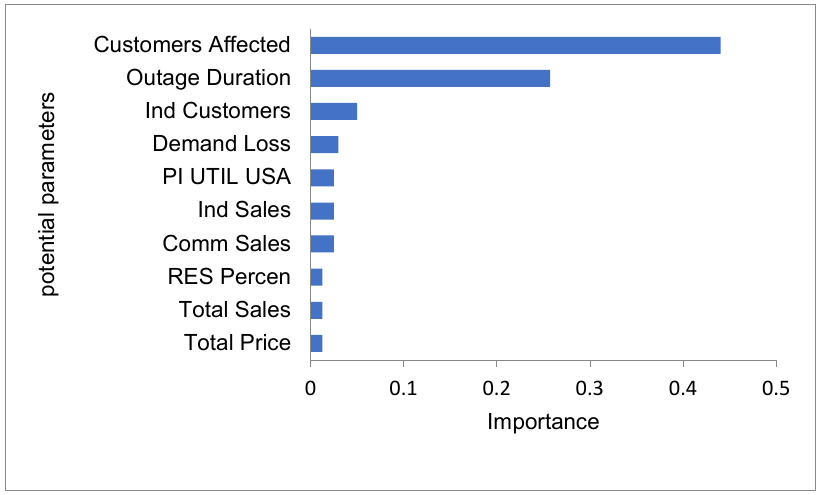
Figure 22. Ranking of top 10 important parameters for revenue loss prediction for the storm disaster Figure 22. Rankingoftop10importantparametersforrevenuelosspredictionforthestormdisastercategory. category.